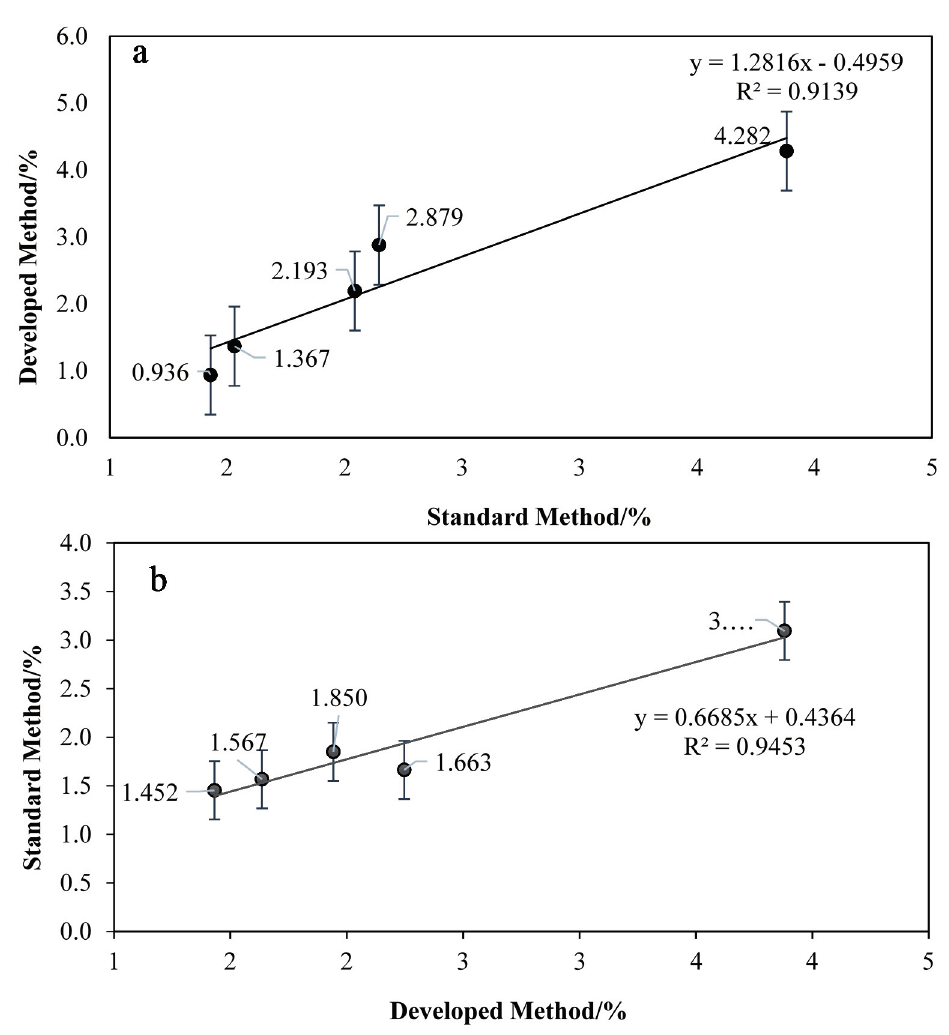
Figure 6. Correlation of FFA concentration between developed method and MPOB standard titration method using ( a ) Candida antarctica A (CAL-A) and ( b ) Thermomyces lanuginose (TL) lipases as catalyst during aminolysis of FFAs to